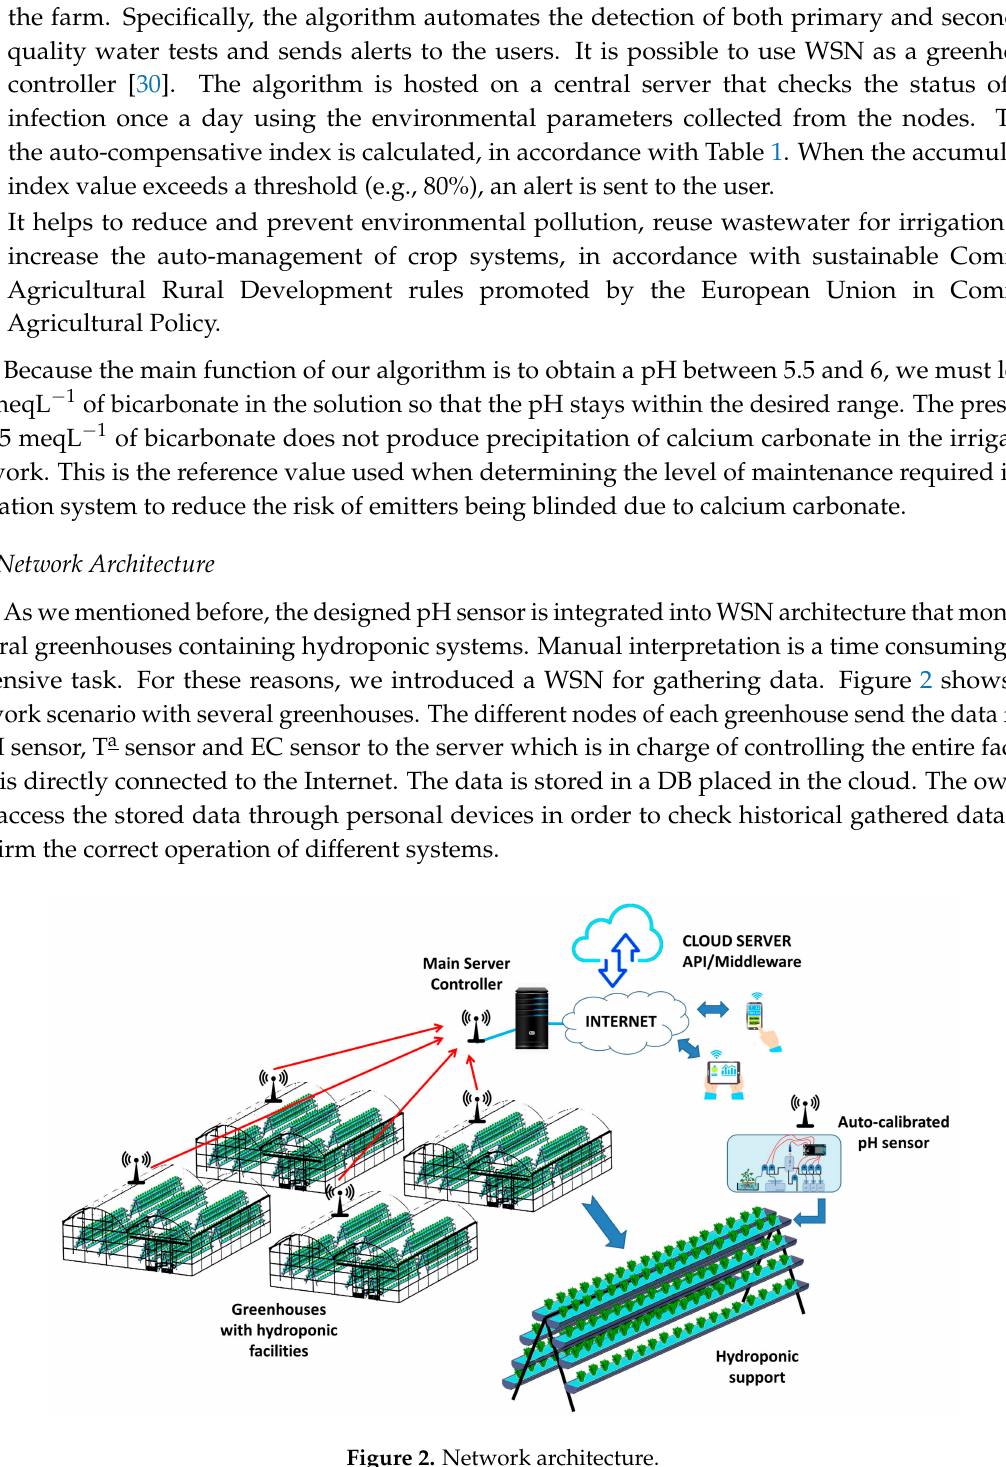
Figure 2. Network